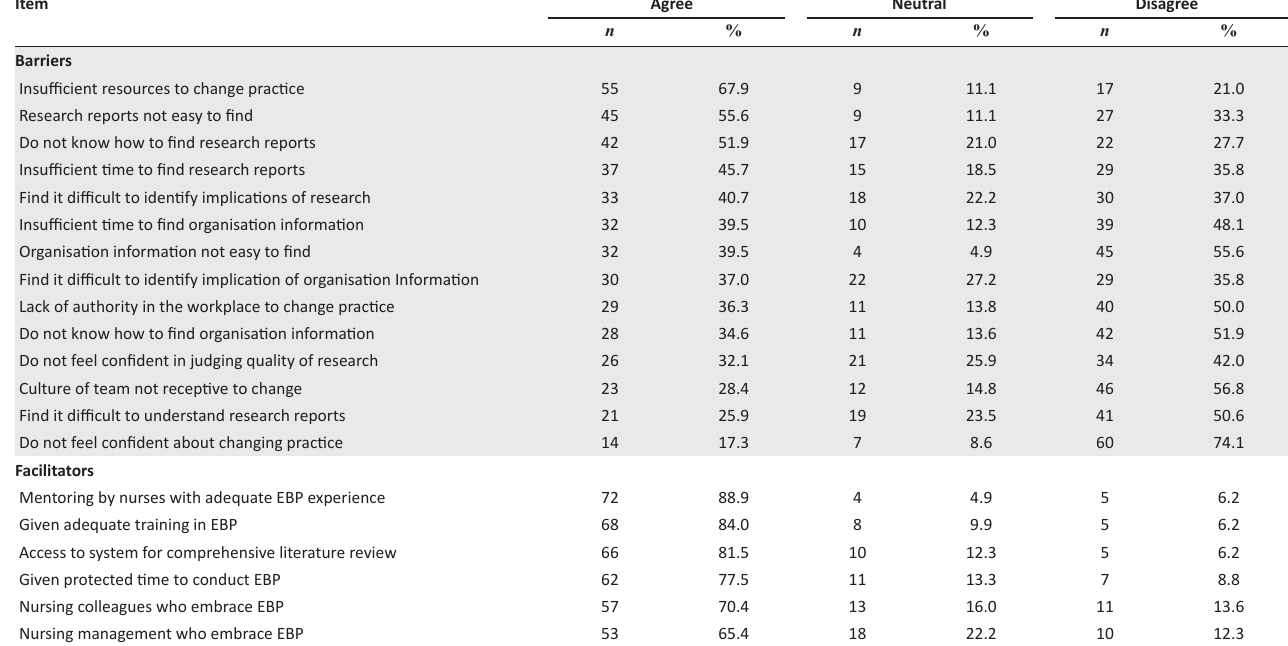
TABLE 3: Barriers to and facilitators of evidence-based practice in prevention of mother-to-child transmission.